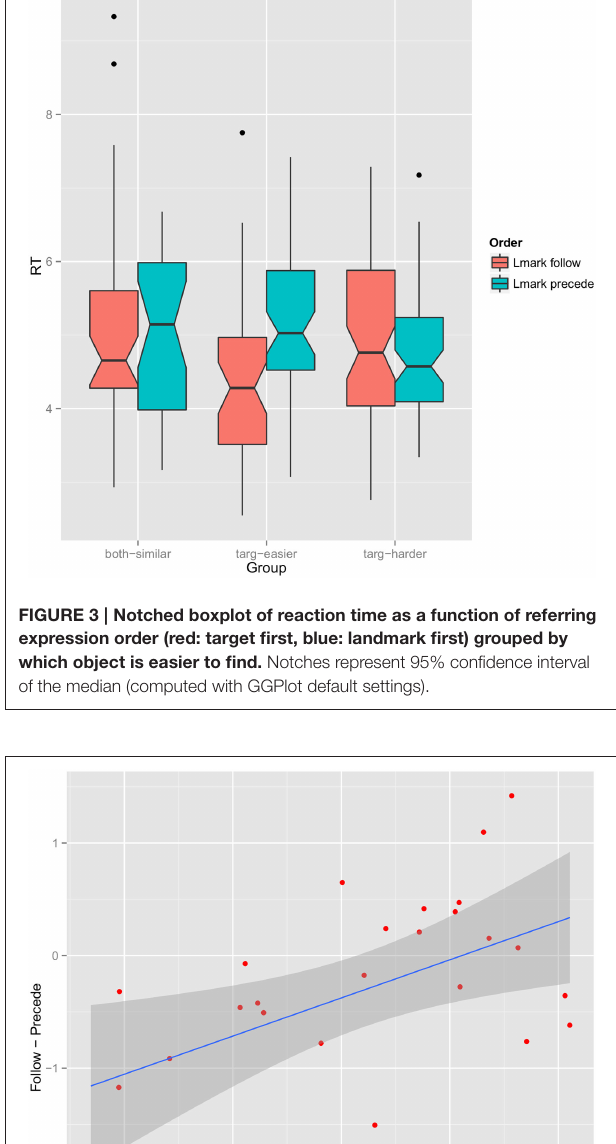
analogous quantity for the two relative referring expressions, median ( follow − precede ). Points on the left represent instances where the target is found faster than the landmark in